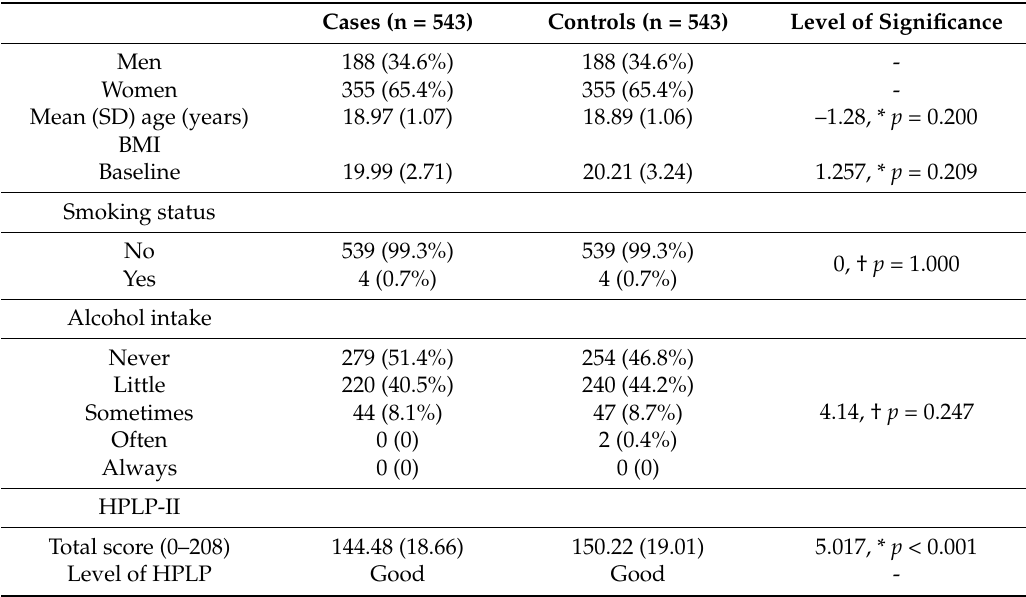
Table 1. Baseline characteristics of cases and controls of study